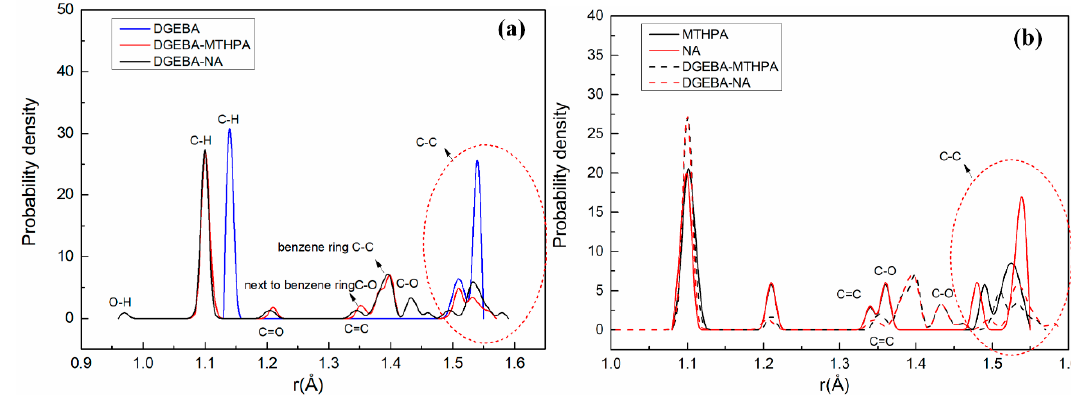
Figure 4. Comparison of bond-length distributions. ( a ) The primary crosslinking structure and the epoxy resin DGEBA; ( b ) the primary crosslinking structure and the curing agents MTHPA and NA.